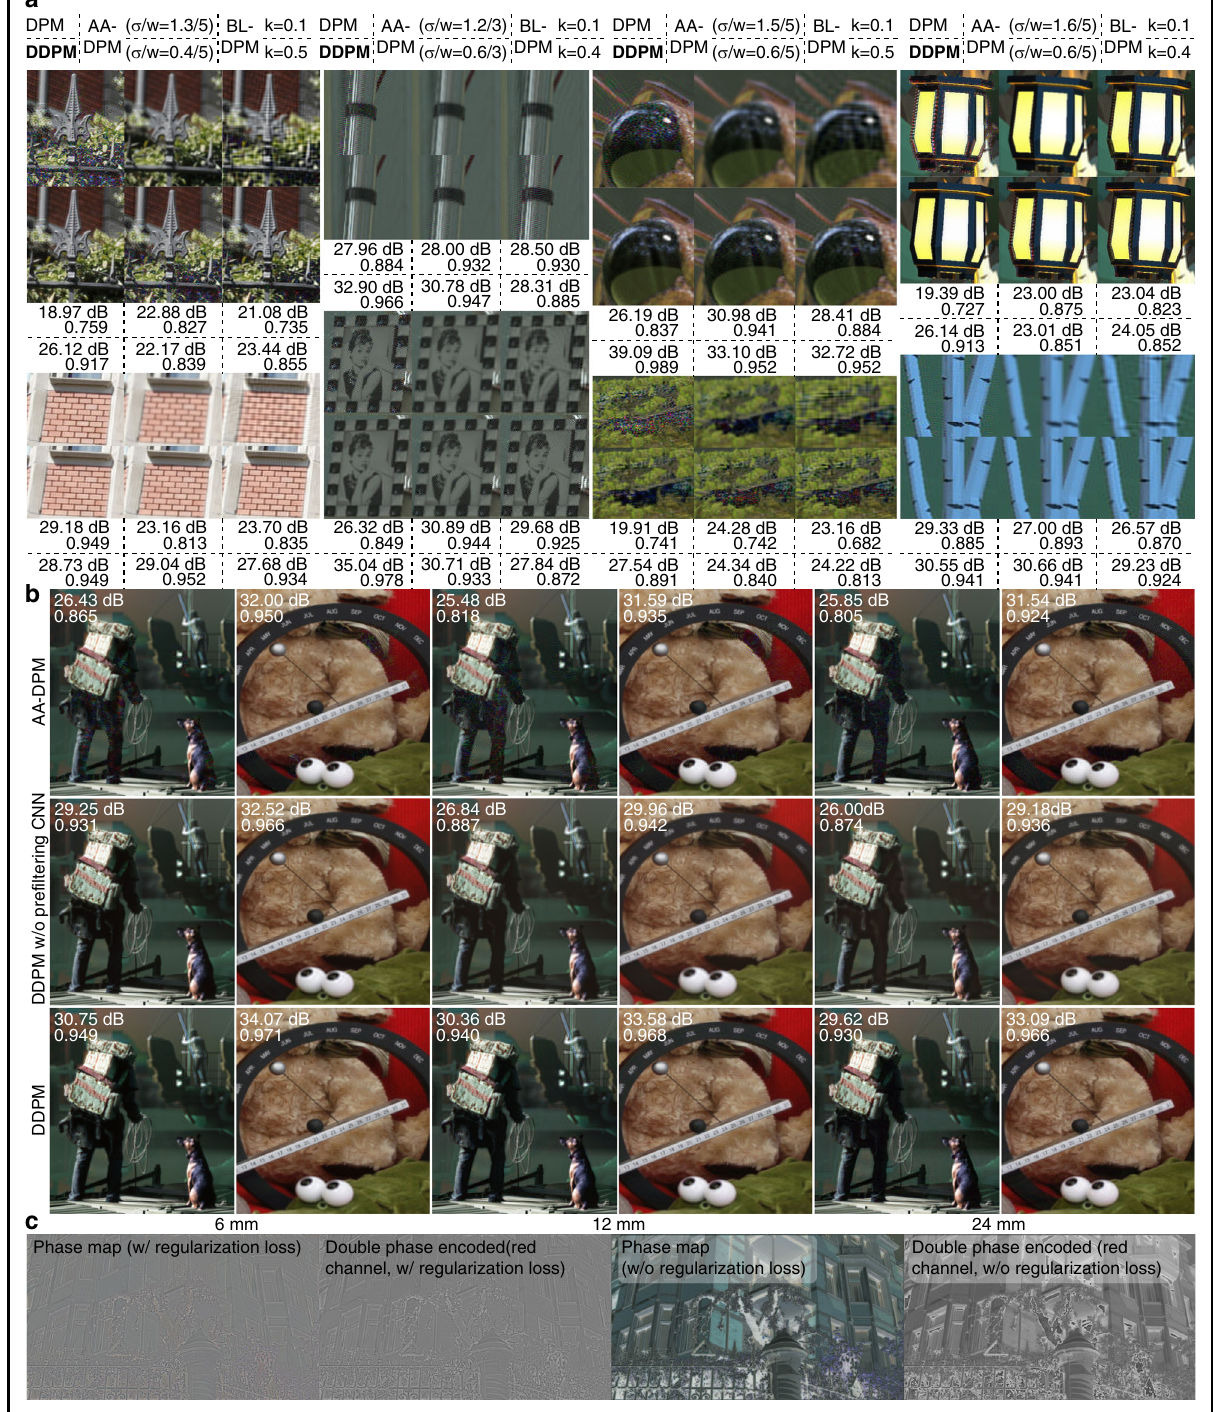
Fig. 5 Performance evaluation of DDPM. a Comparison of simulated reconstruction using DDPM, AA-DPM, and BL-DPM for midpoint hologram. For AA- DPM and BL-DPM, two fi lter strengths are applied: the weaker one results in similar sharpness to DDPM; the stronger one results in an artifact-free image. b Comparison of simulated reconstruction using DDPM, DDPM (without the pre- fi ltering CNN), and AA-DPM for target holograms with 6, 12, and 24mm offset to midpoint hologram. The AA-DPM fi lter strengths used for the boat and the couch scene are ( σ = 1.0, w = 5) and ( σ = 0.8, w = 3) respectively. They are the minimal strengths that result in artifact-free images for the midpoint hologram. c Comparison of pre-encoding target hologram phase and its double-phase encoded phase-only hologram predicted by CNNs trained with and without the regularization loss. The hologram plane is offset by